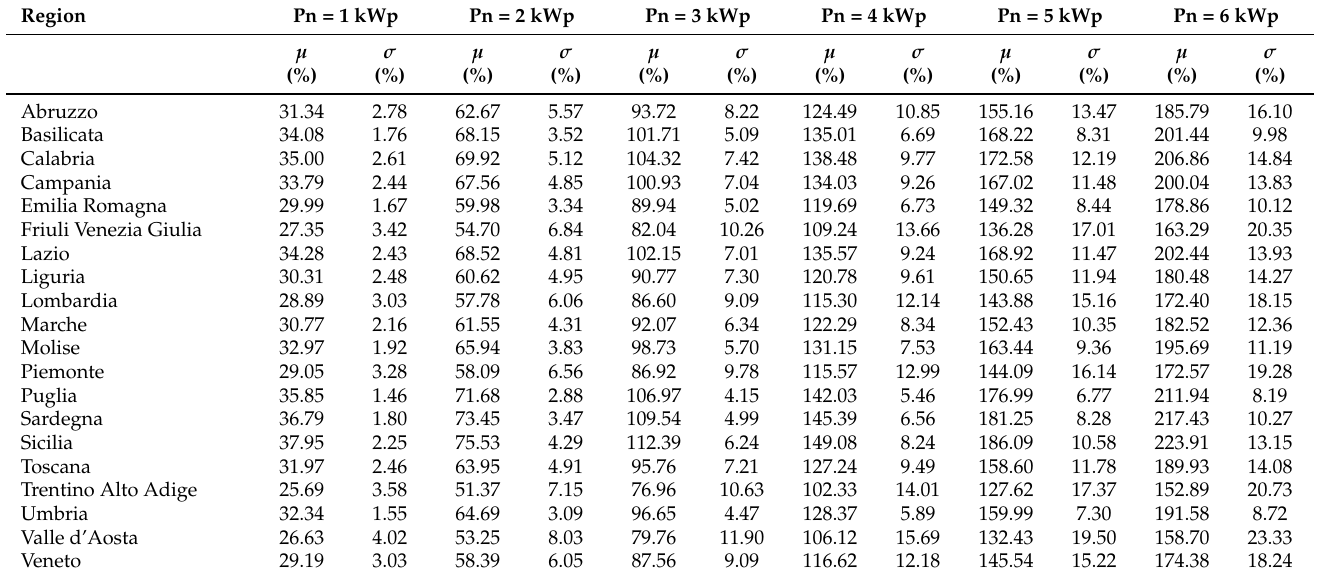
Table 26. CO 2 saving for E L = 4000 kWh with battery.